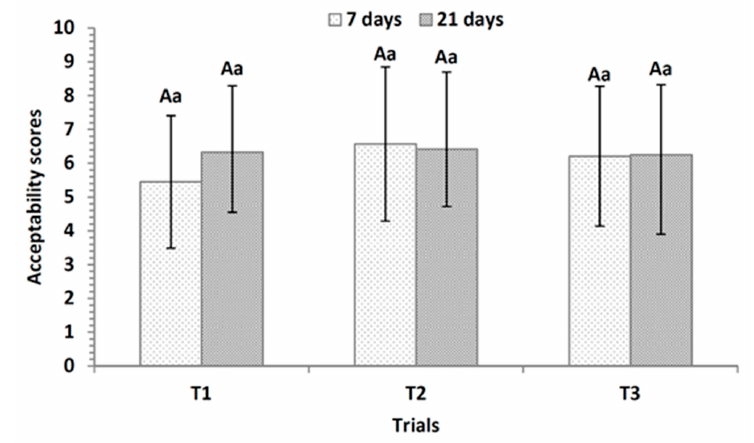
Figure 3. Overall acceptability values (average ± standard deviation) obtained in the sensory analysis with judges ( n = 35) for the fermented dairy dessert trials containing jabuticaba peel ingredients after 7 days and 21 days storage. T1 = control, without lactobacilli adjunct; T2 = commercial probiotic, with L. rhamnosus LR32; T3 = experimental probiotic, with the indigenous culture of L. plantarum CNPC003. A = Same uppercase letters do not differ significantly between the trials studied ( p > 0.05). a = Same lowercase letters do not differ significantly over time for the same trial ( p > 0.05).